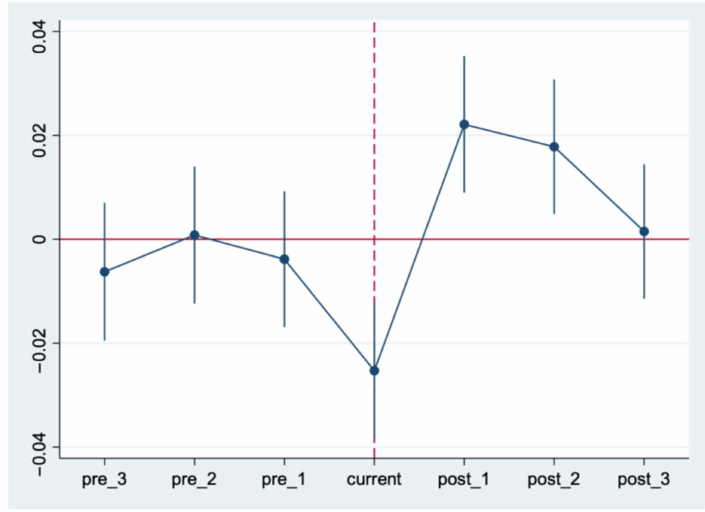
Figure 3. Results of parallel